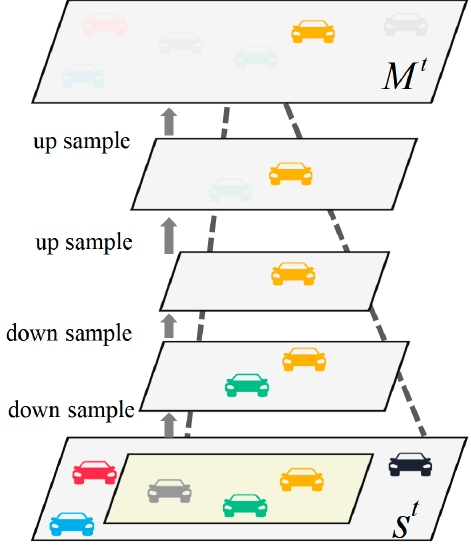
Figure 3. Schematic diagram of mask branching mechanism.